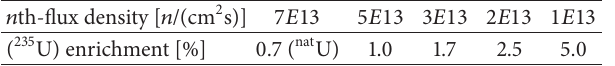
Table 1: Flux density and corresponding U-enrichment for irradi- ation of very low enriched targets and given heat removal system capacity. Irradiating of 280g of U-metal pellets over 100h with subsequent 20h cooling time and about 10h processing time, resulting in 550–740 GBq (15–20Ci) Mo-99 (calibrated 6 days after end of production), is expected to be delivered under given effective thermal neutron flux densities with the suggested 235 U